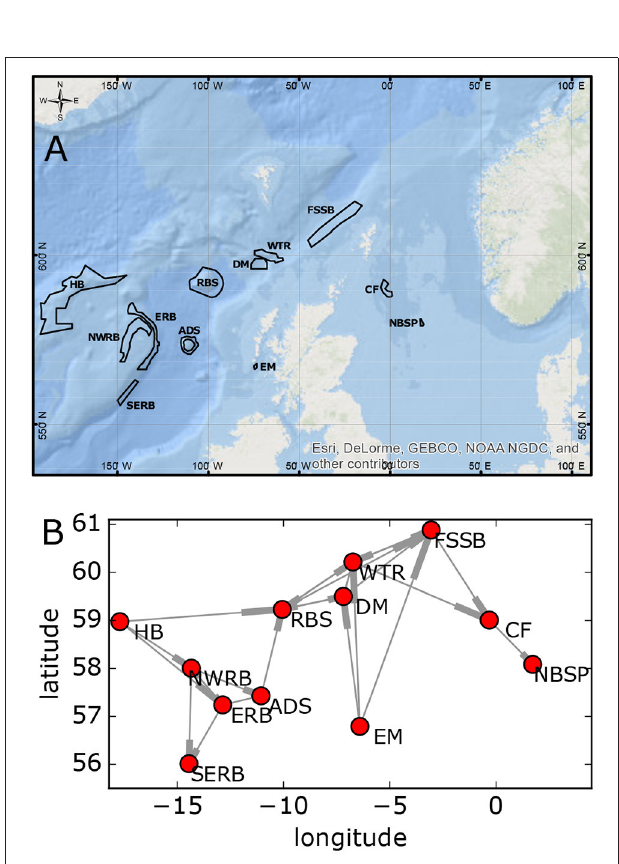
FIGURE 3 | Estimated connectivity of Scottish MPA network for L. pertusa from Fox et al. (2016). (A) Map of the network. (B) Diagram of the connectivity. Connection direction is toward the thickened end of the edge. Site name abbreviations are listed in Table 1 .